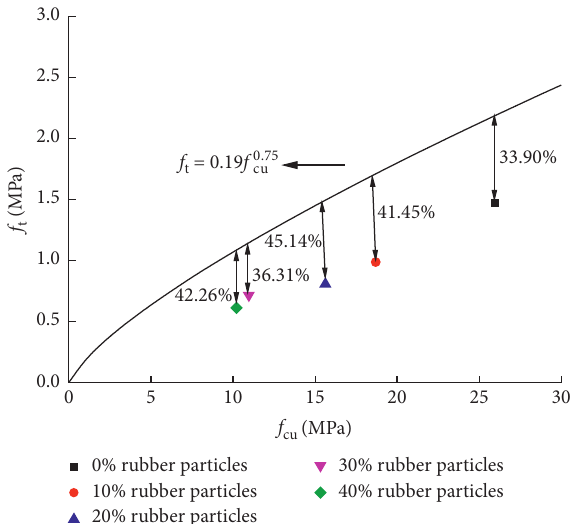
Figure 11: Relationship equation between the compressive strength and tensile strength of concrete.